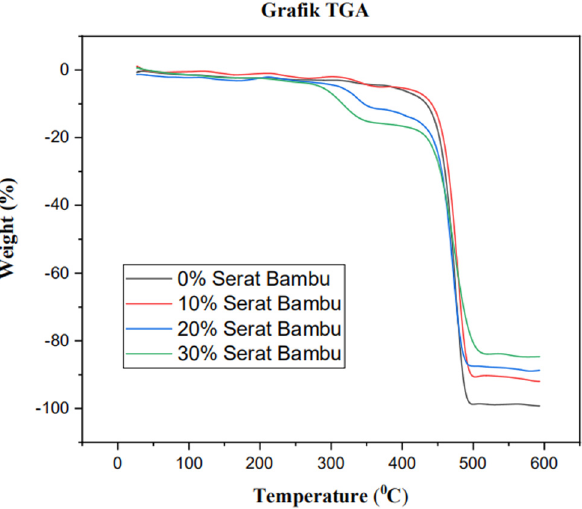
Figure 6: Graph of TGA.